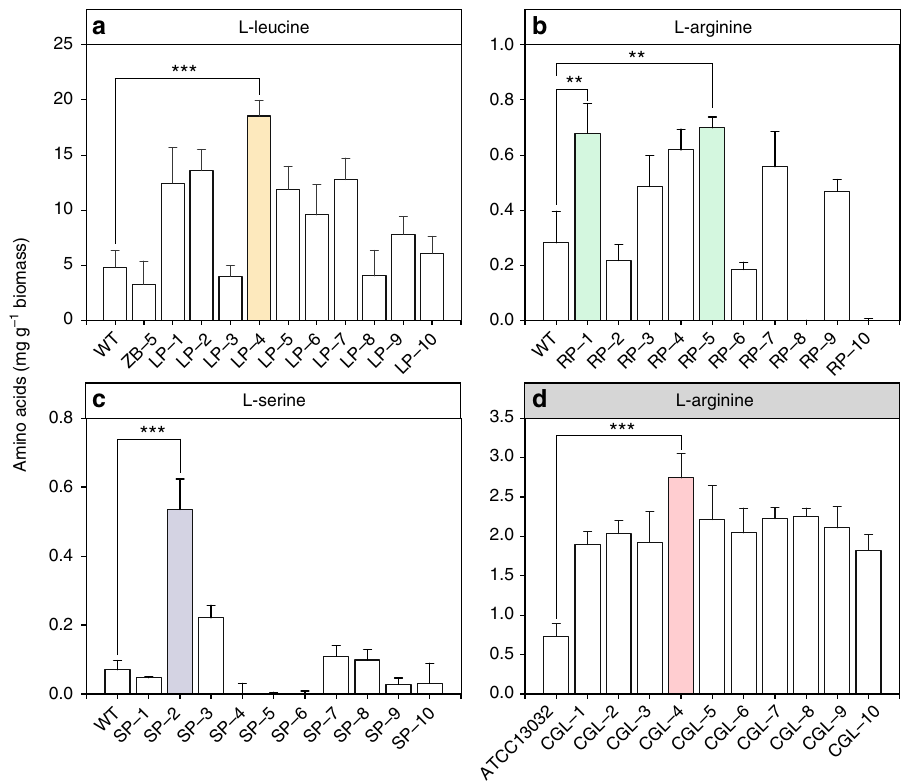
Fig. 5 The amino acids produced by the wild-type and the mutated strains. a L -leucine productions of E. coli mutants selected by the leucine rare codon-rich kan R . b L -arginine productions of E. coli mutants selected by the arginine rare codon-rich kan R . c L -serine productions of E. coli mutants selected by the serine rare codon-rich spec R . d L -arginine productions of C. glutamicum mutants selected by the arginine rare codon-rich kan R . Values and error bars represent the mean and the s.d. ( n = 3). ** P < 0.01, *** P < 0.001 as determined by two-tailed t